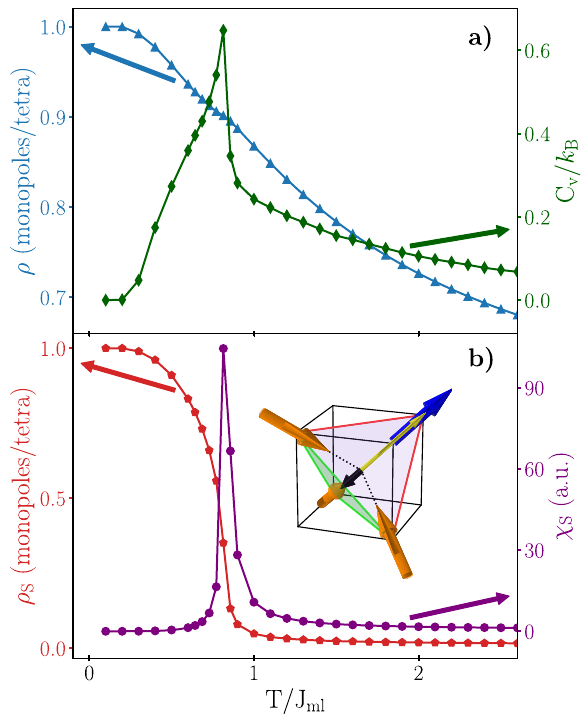
Fig. 3 Zincblende monopole crystal ( J 0 = 0 and γ / J ml = 0.2). An attraction between monopoles of different signs can make the Monopole Liquid crystallise in the Zincblende structure, with spontaneous symmetry breaking. The ordered charges in the crystal contrast with the partial disorder of the spins that produce this crystal structure 23 , in what is known as the magnetic moment fragmentation 26 . a Speci fi c heat ( C V , right axis) and density of single monopoles ( ρ , left axis) across the temperature at which the crystallisation transition occurs. b The order parameter for crystal formation (the staggered monopole density ρ S , left axis) and its fl uctuations χ S (right) measured in the same temperature range. We have subtracted the contribution of the pure vibrational degrees of freedom from C χ fl ects the spontaneous symmetry breaking. The inset V . The peak in S re to panel b) shows a magnetoelastic con fi guration of minimum energy for a positive single monopole in an up tetrahedron. The total magnetic moment (thin yellow arrow) points along the minority spin (blue arrow); it is one among a total of 8 different directions: 4 associated with positive and 4 with negative single monopoles, or 1 per spin con fi guration. The short black arrow corresponds to δ r , the O − 2 displacement of minimum energy for this magnetic con fi guration. There are only 4 different displacements δ r , since they do not invert under time reversal, and they are always directed towards the face of the tetrahedron with 3 antiferromagnetic links (with the three spins on the corners sharing the same sign), coloured green here. The fl uctuation of the fragmented magnetic moment implies that δ r is also fl